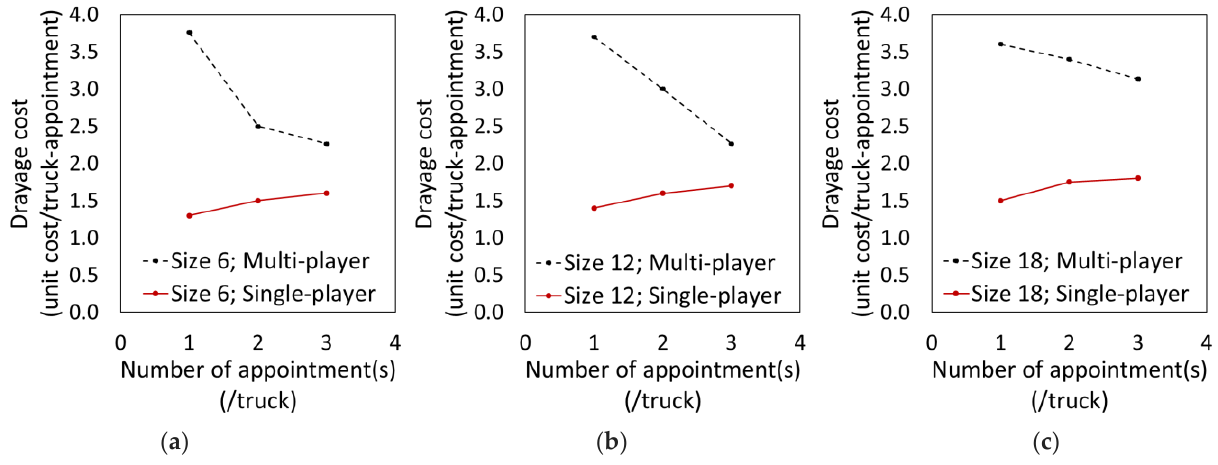
Figure 6. Drayage cost comparison for different problem sizes: ( a ) 6 appointments, ( b ) 12 appoint- ments, and ( c ) 18 appointments.